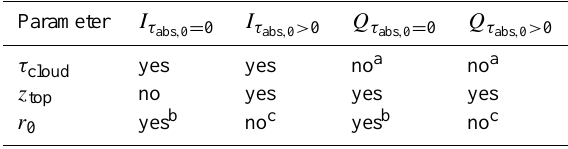
Table 1. Characteristic sensitivity of the O 2 A band to cloud optical thickness, top height and droplet